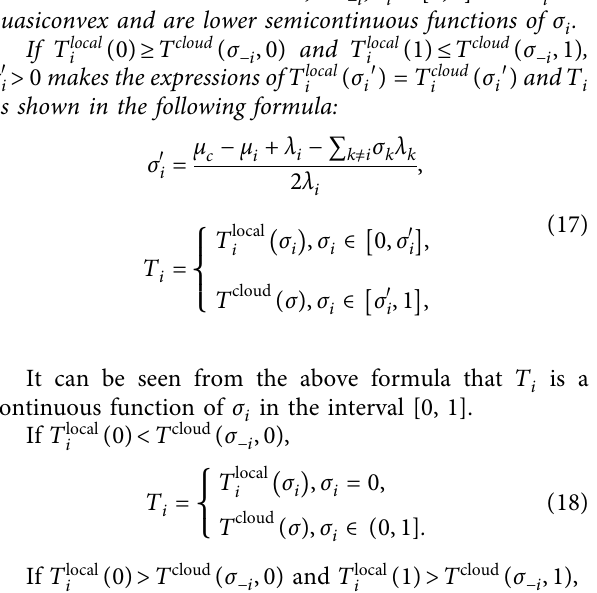
build the corresponding data traffic management model. The specific process mainly includes the following.